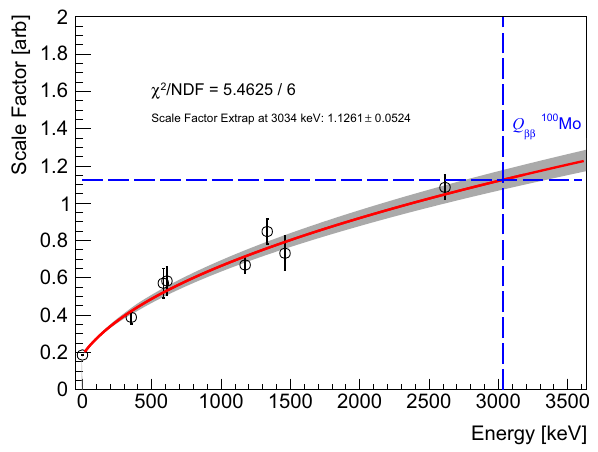
Fig. 12 Energy bias in physics data. Here the best fit central value vs true value for each peak in the physics data is fit against a quadratic polynomial. The residual evaluated at Q ββ is then obtained from this fit giving an estimate for the energy scale